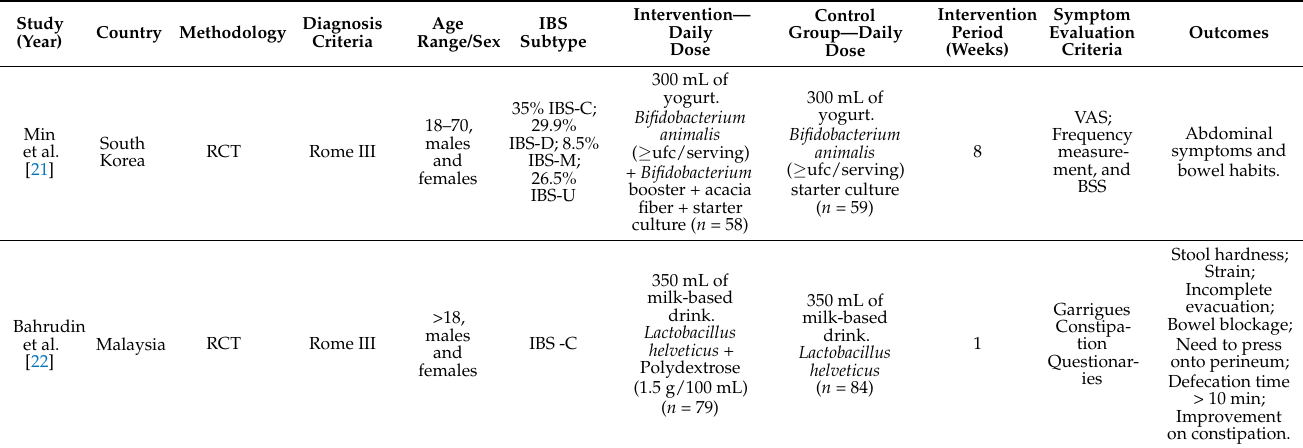
Table 2. Characteristics of the studies included in this